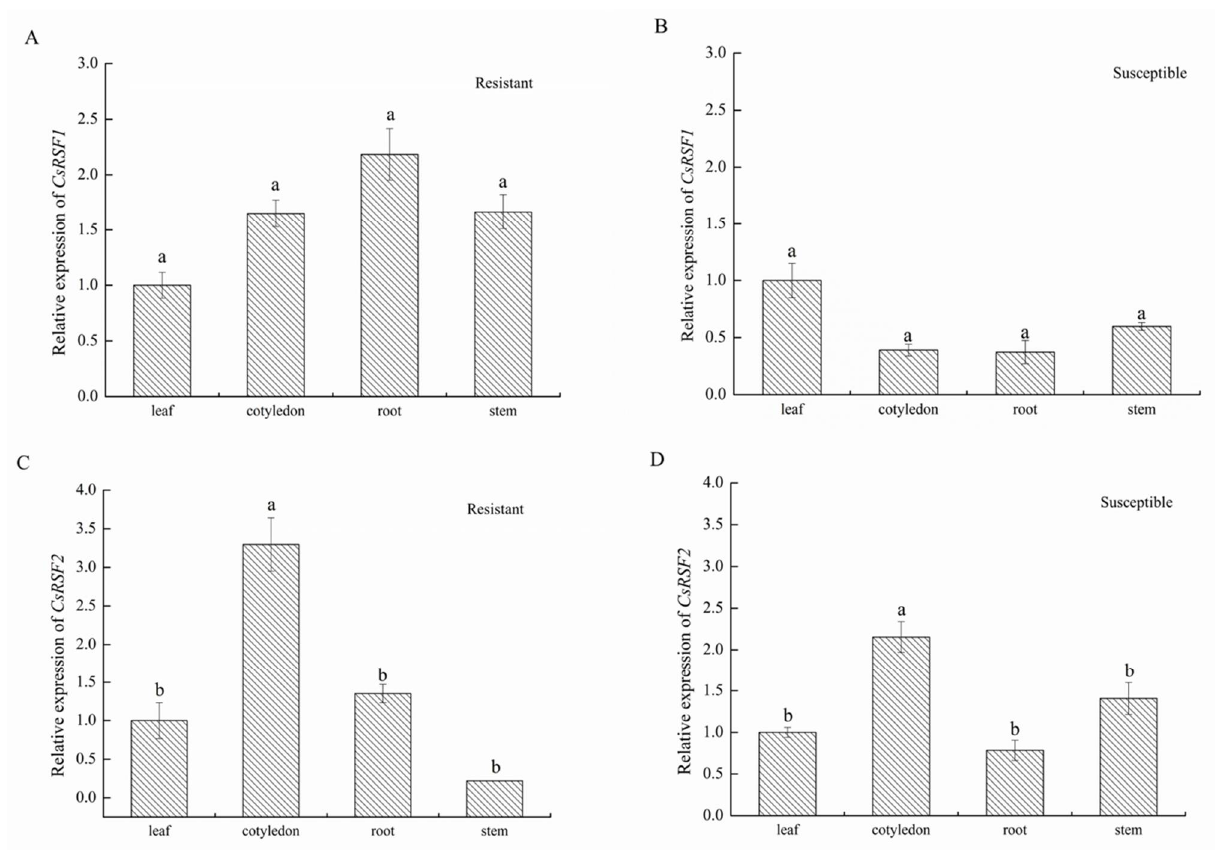
Figure 2. Expression patterns of CsRSF1 and CsRSF2 in various cucumber organs (leaf, cotyledon, stem and root). ( A ) Expression pattern of CsRSF1 in resistant variety. ( B ) Expression pattern of CsRSF1 in susceptible variety. ( C ) Expression pattern of CsRSF2 in resistant variety. ( D ) Expression pattern of CsRSF2 in susceptible variety. The expression level in the leaf was normalized as 1. Expression analysis of candidate genes using the 2 − ∆∆ C t method. Data are means ± SD from three biological replicates per cultivar. Different letters (a,b) above the bars indicate a significant difference determined by Student’s t -test ( p < 0.05).